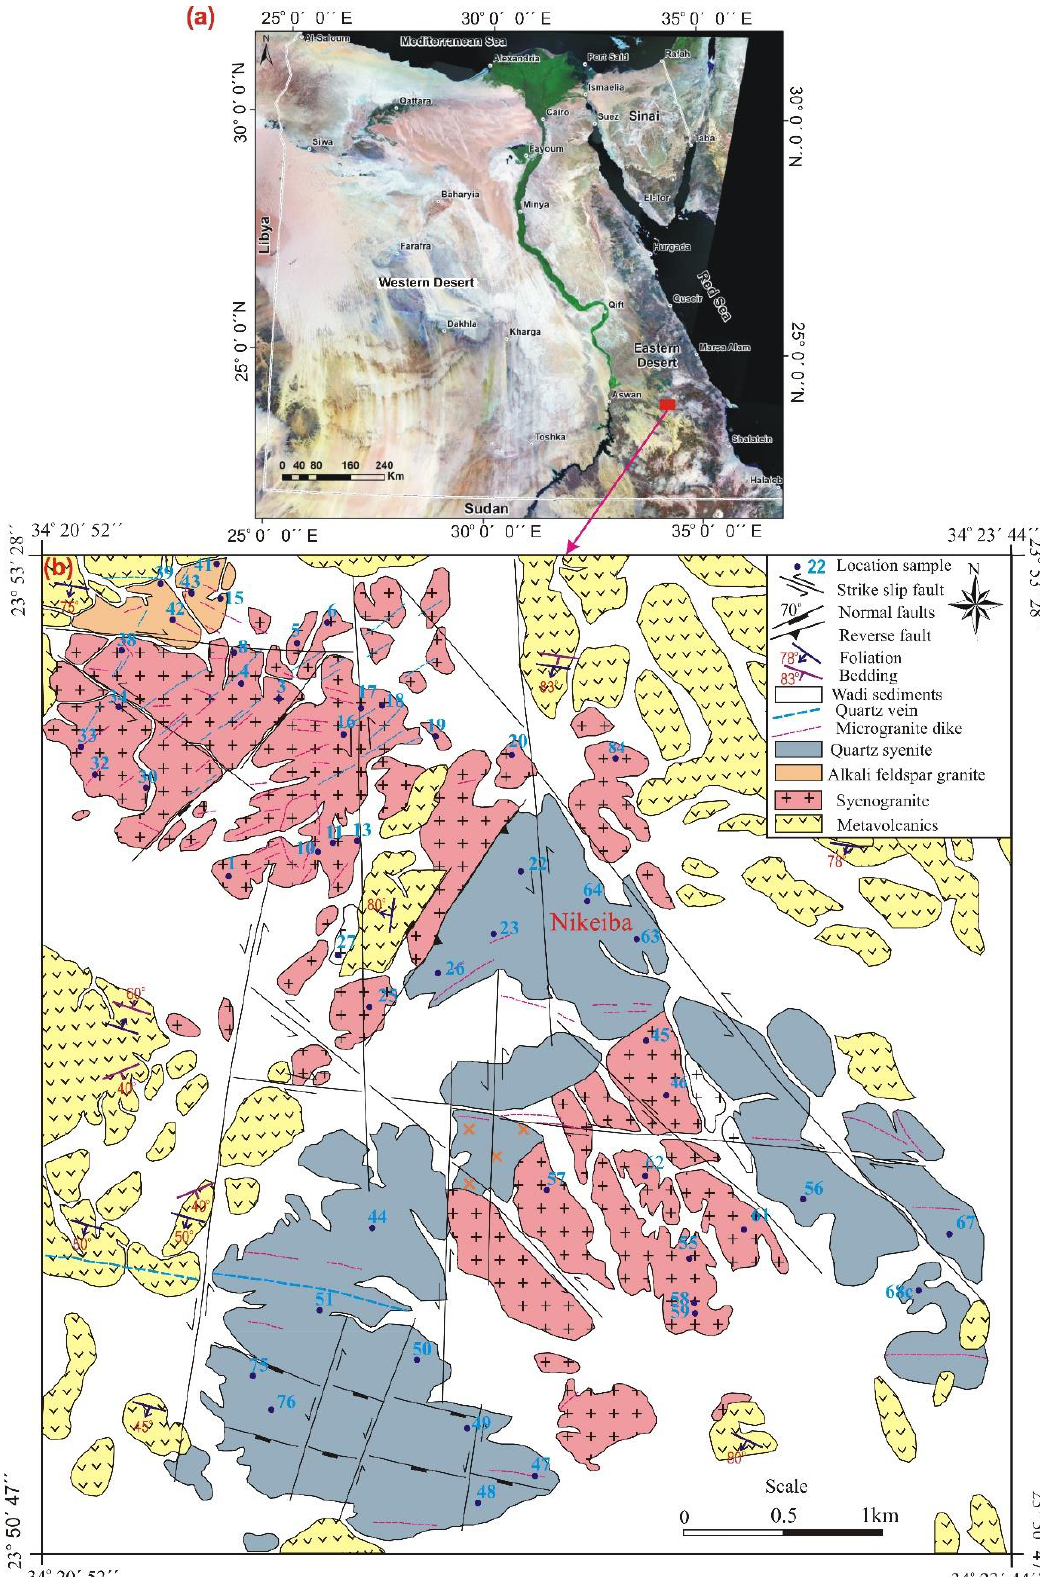
Figure 1. ( a ) Physiographic map and ( b ) detailed geologic map showing locations of the analyzed samples from Nikeiba, Southeastern Desert, Egypt.